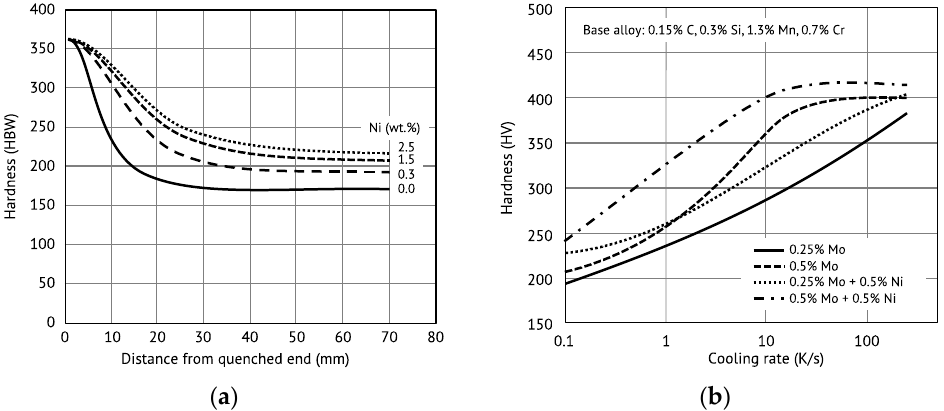
Figure 4. ( a ) Jominy curves indicating the effect of increasing Ni content on the hardenability of grade S460 low ‐ carbon structural steel; ( b ) hardness in function of defined cooling rate by dilatom ‐ eter testing demonstrating hardenability performance of molybdenum, nickel and synergies be ‐ tween both.